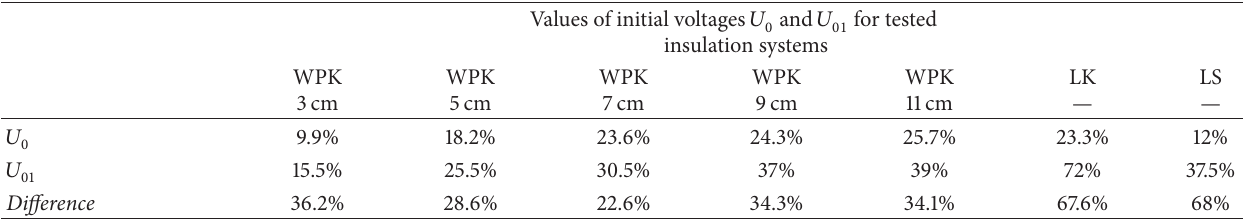
Table 5: Comparison of PD initial voltages for tested insulation systems, during which emission spectra may have increased intensity and the broadest